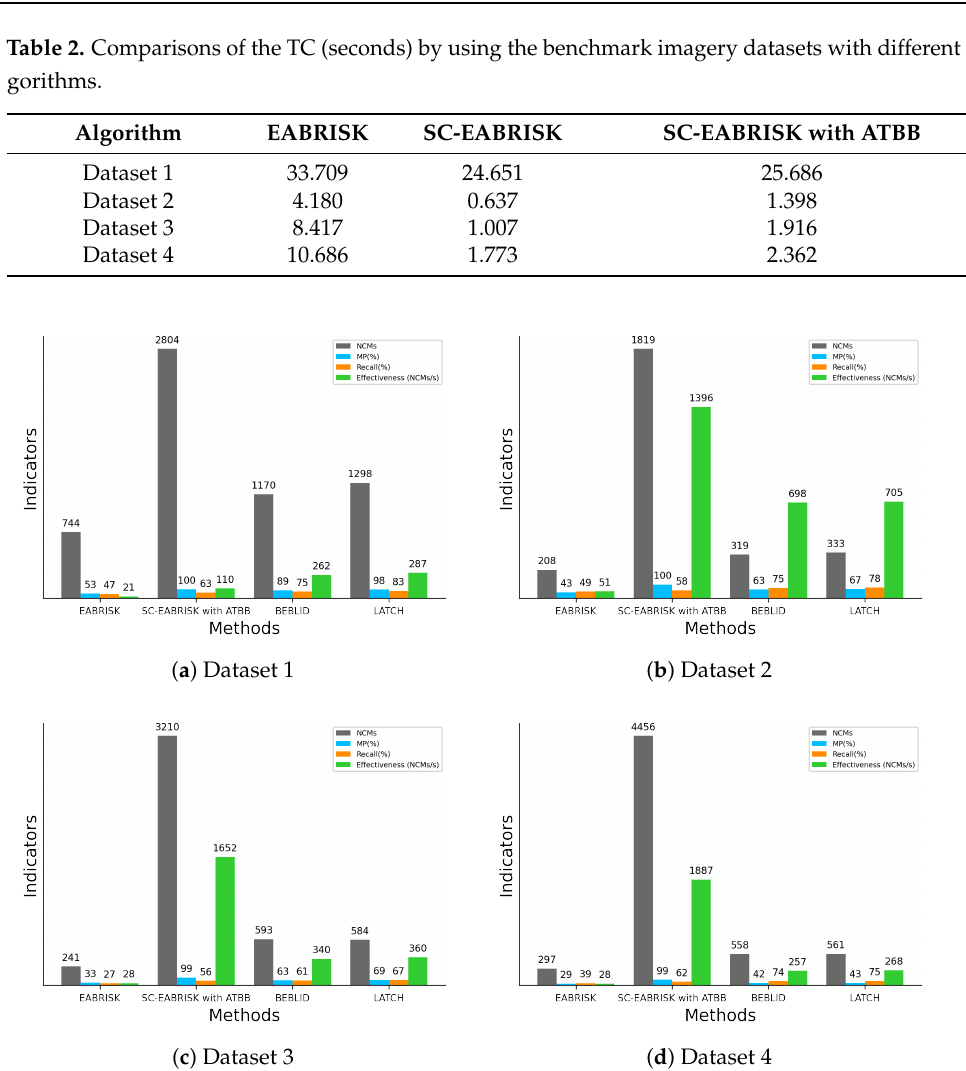
Figure 7. Numerical analyses of the image matching results by using the benchmark imagery